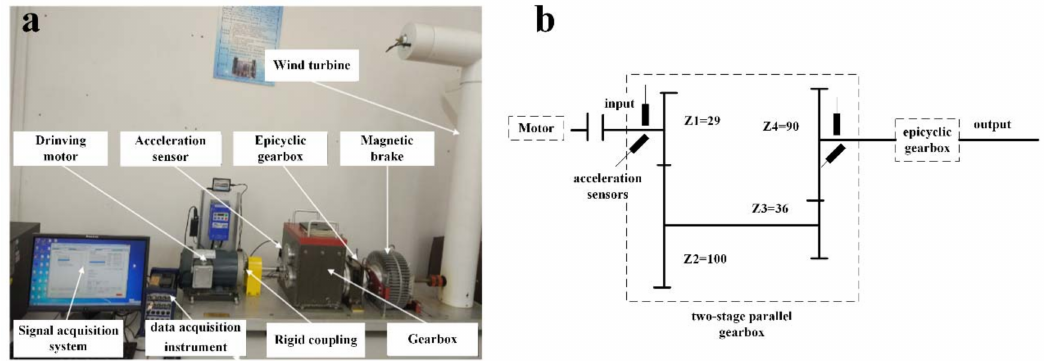
Figure 11. The Wind Turbine Diagnostics Simulator (WTDS) experimental setup ( a ) schematic of the testing gearbox ( b